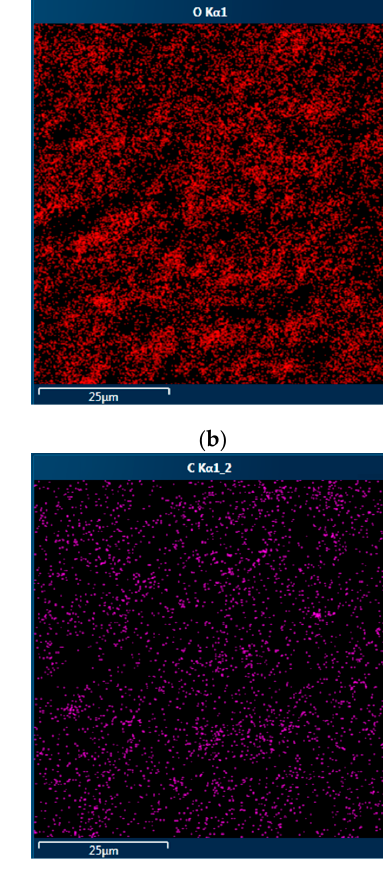
Figure 7. Elemental mapping of the Al 2 O 3 + 30%TiC nanocomposite machined surface in oil medium: